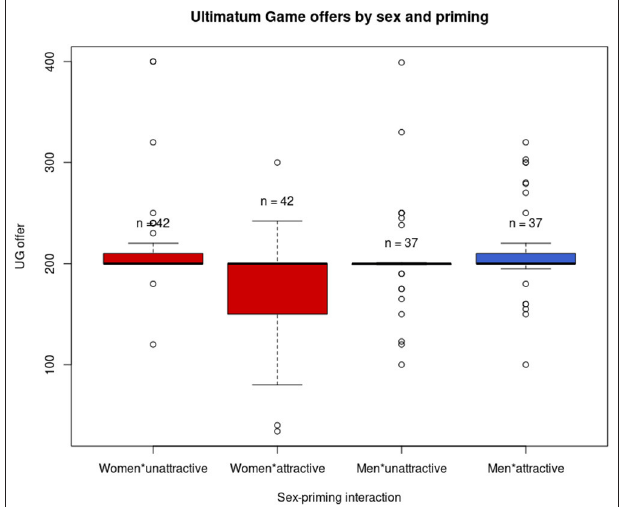
FIGURE 1 | Ultimatum Game (UG) offers by participant sex (women shown in red and men in blue) and priming. Priming had a negative effect on UG offers in the overall sample and women. The difference in (un)attractiveness-primed women is visible in the two left boxplots. In men, no substantial difference was observed. The boxes show the interquartile range (IQR), and the bold line denotes the median. Whiskers can indicate either x 1.5 IQR from median or minimum and maximum in the absence of outliers (shown as circles).